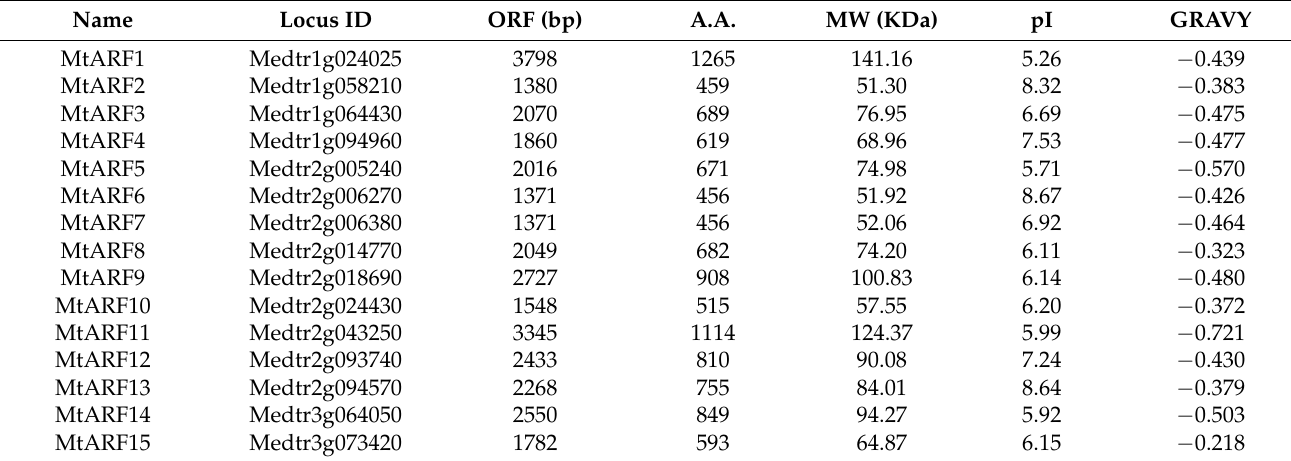
Table 2. Information on MtARF